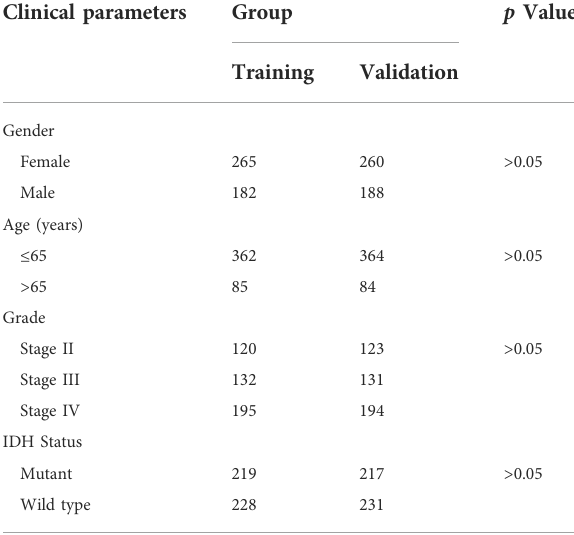
TABLE 1 The clinical characteristics of glioma patients in the training and validation group. Clinical